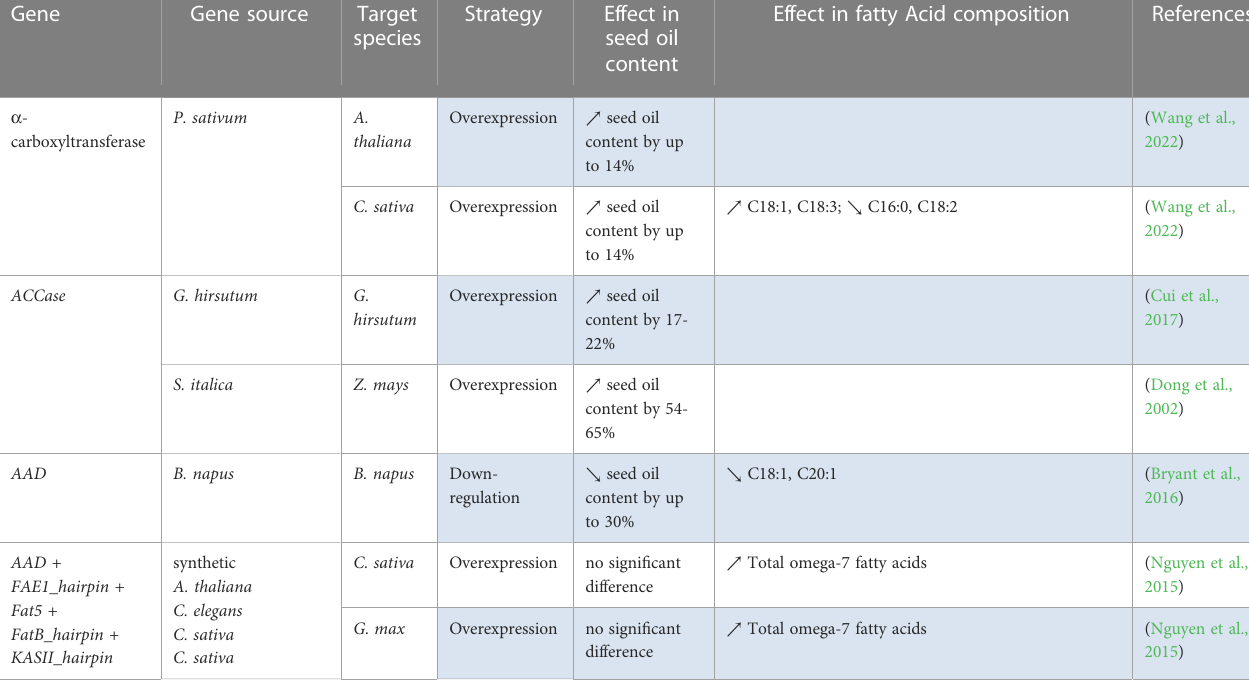
TABLE 4 List of “ push ” genes manipulated to enhance oil yield and/or change the FA composition in seeds.